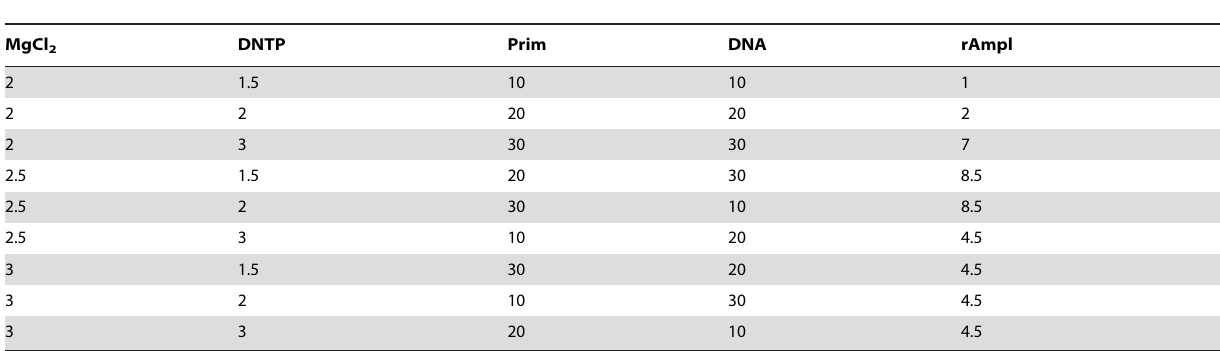
Table 6. Rank ordering of the original AP-PCR OA-data (Table S1).